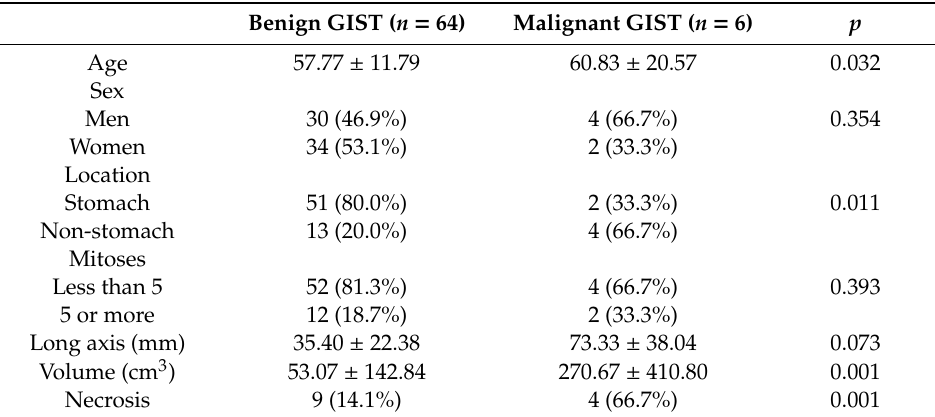
Table 1. Clinical characteristics of patients with